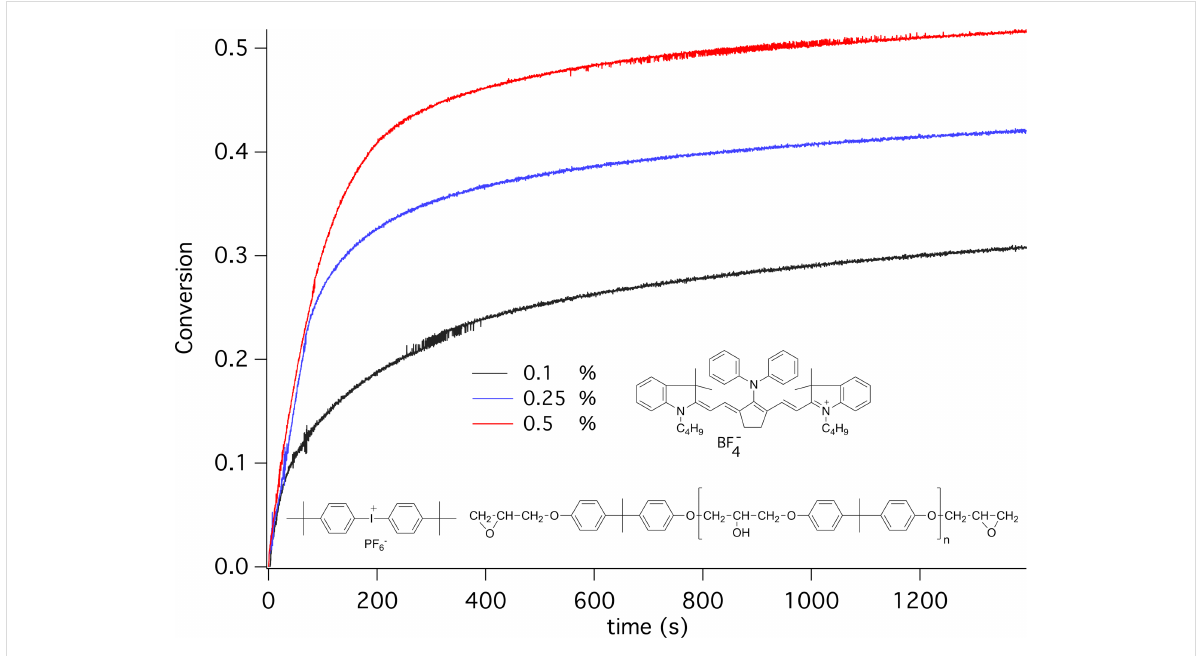
Figure 3: Cationic photopolymerization of an epoxide (Epikote 828) initiated by excitation of the absorber 36 and bis(4- tert -butyl phenyl)iodonium hexafluorophosphate (2 wt %) applying different NIR sensitizer concentrations with an NIR-LED source emitting at 805 nm with an intensity of 1.2 W cm –2 . (From [65]. Schmitz, C.; Pang, Y.; Gülz, A.; Gläser, M.; Horst, J.; Jäger, M.; Strehmel, B., New High-Power LEDs Open Photochemistry for Near-Infrared-Sensitized Radical and Cationic Photopolymerization. Angew. Chem., Int. Ed. 2019, 58 (13), 4400–4404. Copyright Wiley-VCH Verlag GmbH & Co. KGaA. Reproduced with